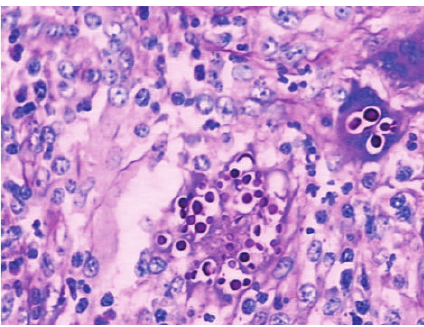
Figure 5: The cervical lymph node excisional biopsy revealed a lymphohistiocytic background with several blue, spherical struc- tures that were surrounded by clear halos, which are indicative of Cryptococcus.